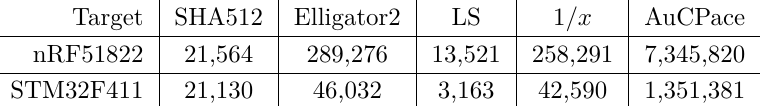
Table 6: Cycle counts for the nRF51822 Cortex M0 (STM32F411 Cortex M4) microcon- trollers running at 16 MHz for SHA512, Elligator2, a X25519 Montgomery ladder step (LS), Inversion (1 /x ) and a complete partially augmented AuCPace protocol